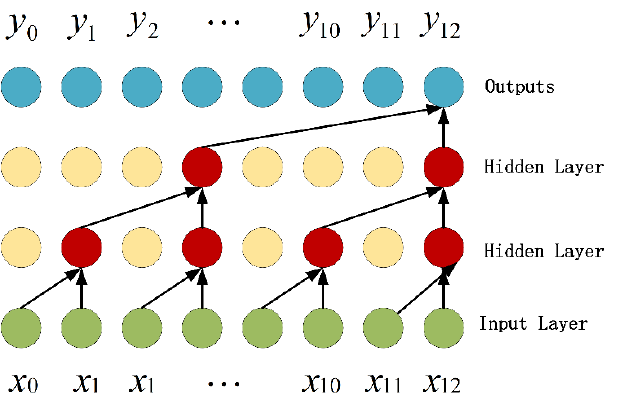
Figure 9. The causal convolution layer of TCN multiple extension: x 1 , x 2 , · · · , x 12 is the input sequence, and y 1 , y 2 , · · · , y 12 is the output sequence. It is admitted that the input history length of the network is the same as the future prediction